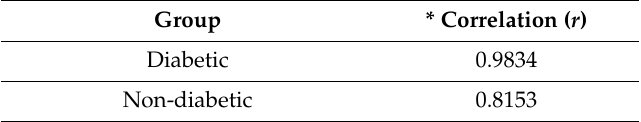
Table 2. * Karl Pearson’s product–moment correlation ( r ) for gingival crevicular blood glucose values and peripheral finger-stick blood glucose values in the diabetic and the non–diabetic group, respectively.